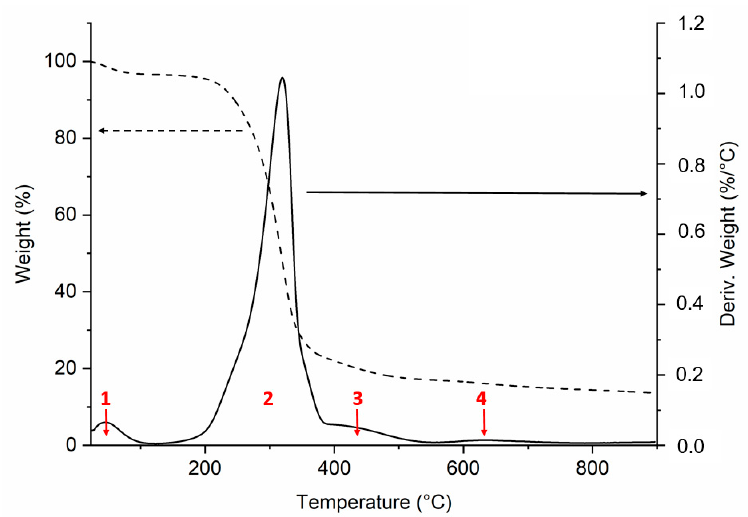
Figure 4. TGA of the KBC, dashed line corresponds to the weight loss; and the black line represents the derivative thermograph. The red numbers correspond following processes: (1) water loss; (2) KBC main degradation; (3) decarboxylation and ring formation reactions, and (4) char formation.